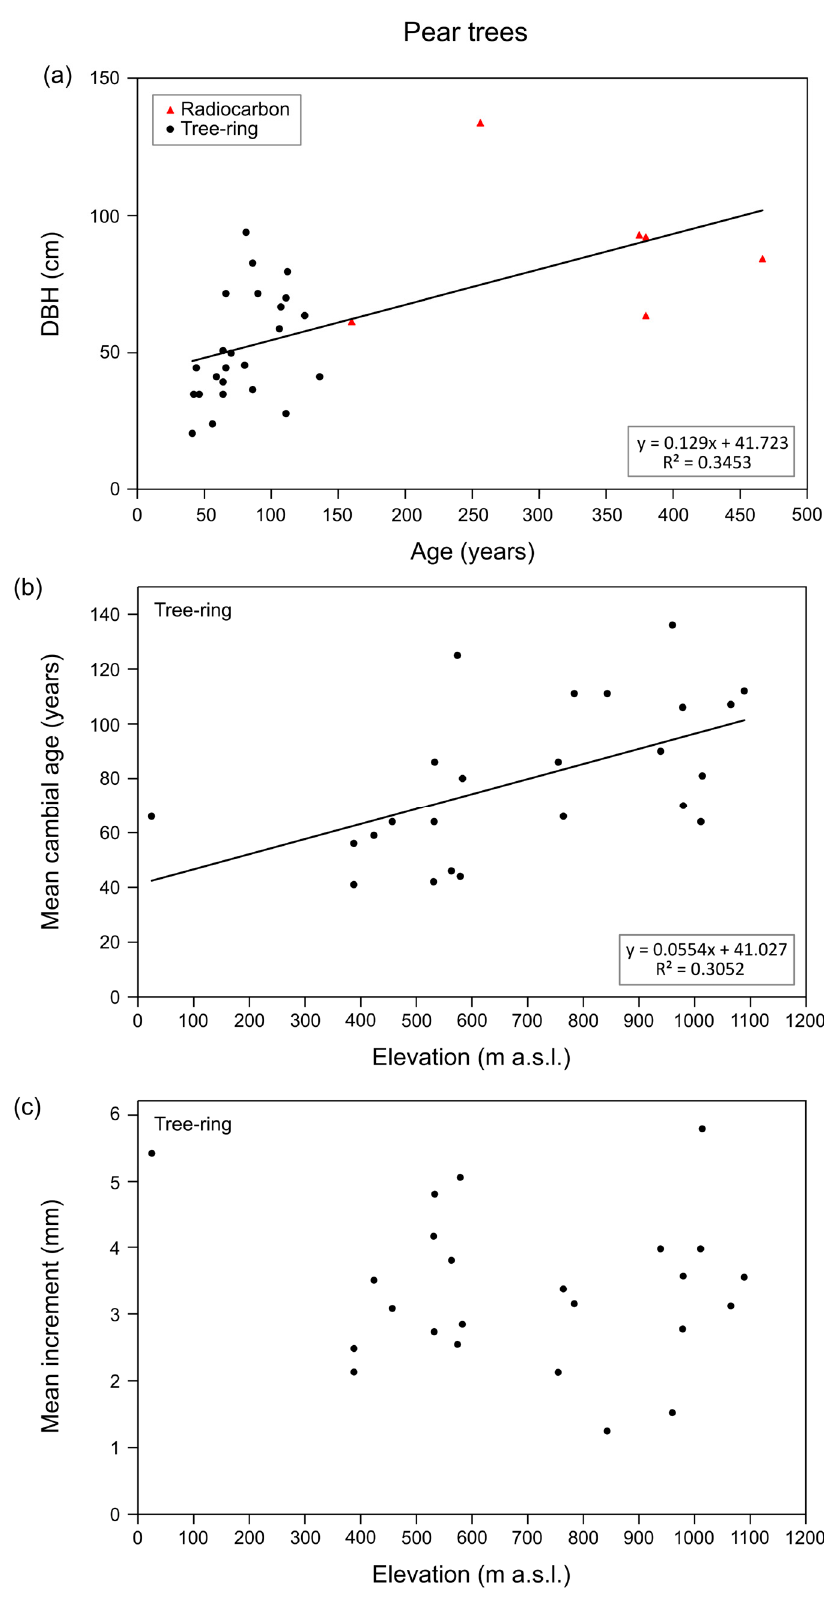
Figure 5. Focus on pear trees; linear regression and R 2 value are displayed when the linear correlation was statistically significant. ( a ) Age vs. diameter (DBH). ( b ) Age (tree-ring only) vs. elevation. ( c ) Mean radial increment vs. elevation.